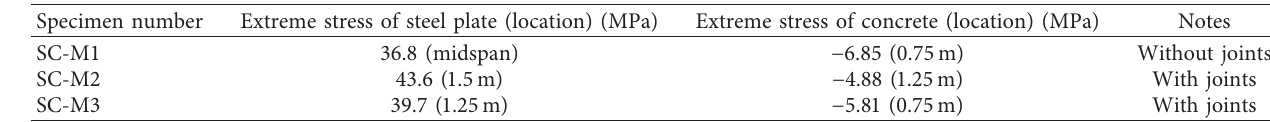
Figure 18: Average strain distribution of jointed specimens in flexural experiment. Table 2: Extreme stress of bending test